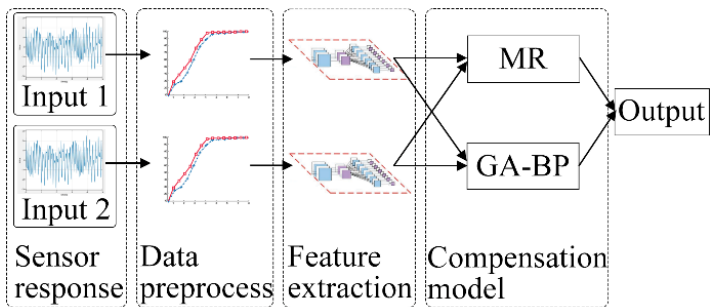
Figure 2. Modified flow model. Input 1 and Input 2 are response voltages of the NO gas sensor and flow sensor, respectively.